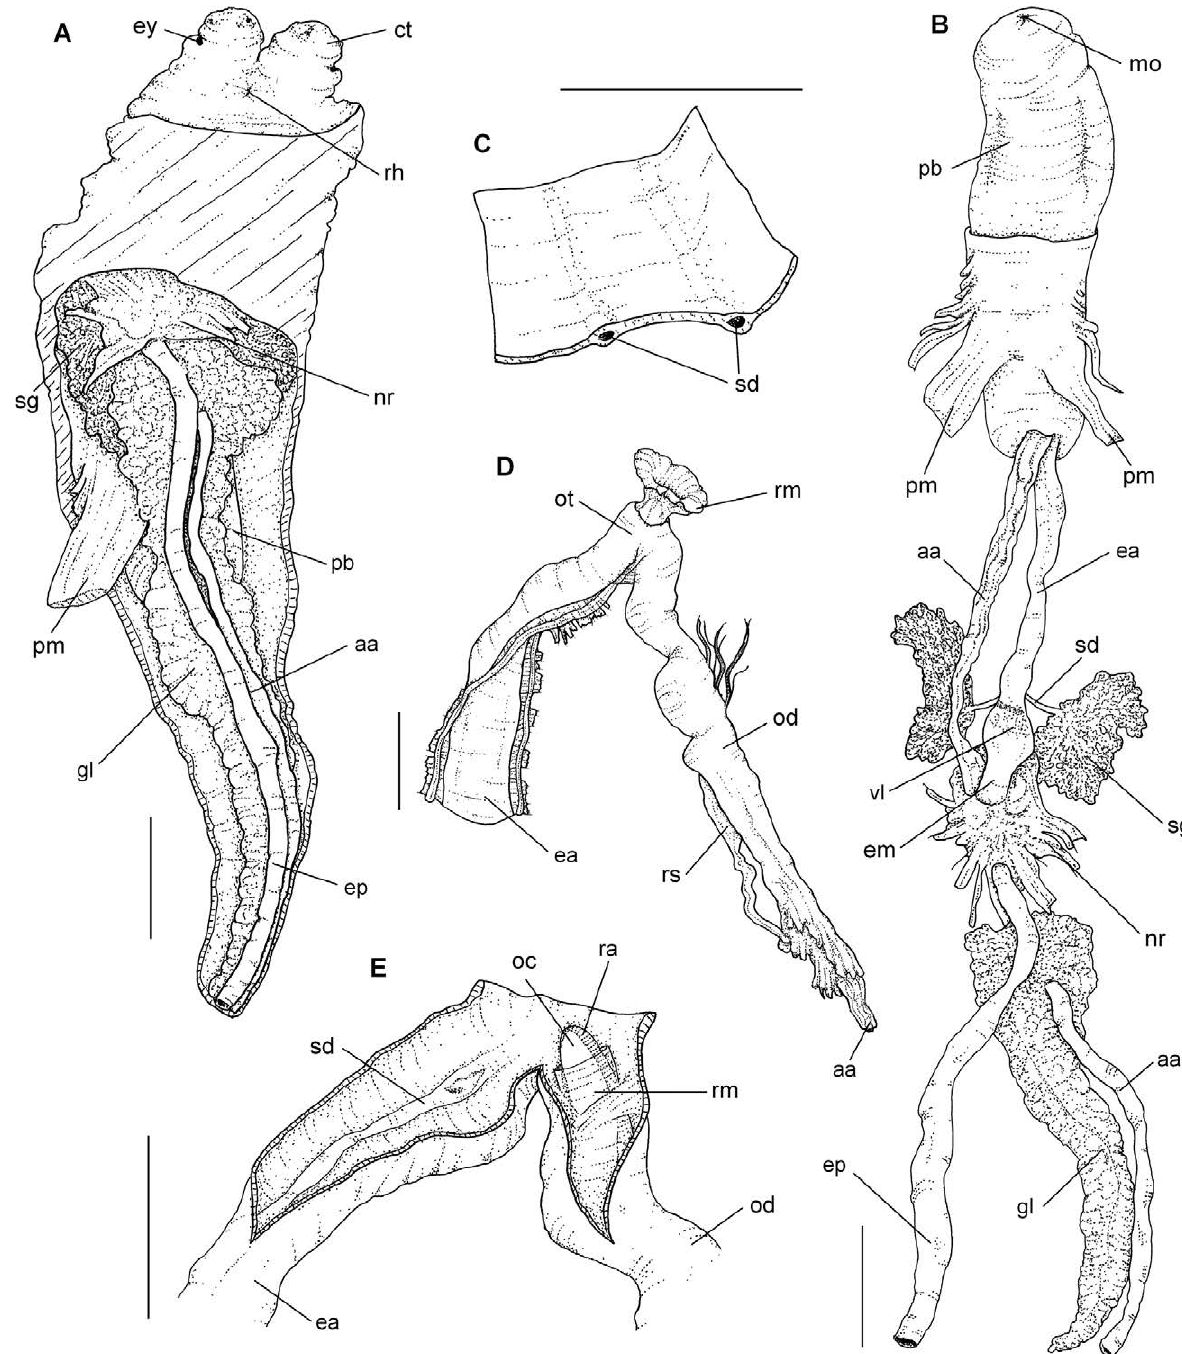
Fig. 3.- Pustulatirus ogum . A, haemocoel in ventral view; B, anterior digestive system; C, lumen of anterior esophagus; D, buccal mass in lat- eral view; E, buccal mass in lateral view, opened longitudinally. Abbreviations: aa, anterior aorta; ct, cephalic tentacle; ea, anterior esophagus; ep, posterior esophagus; ey, eye; gl, gland of Leiblein; mo, mouth opening; nr, nerve ring; oc, odontophore cartilage; od, odontophore tube; ot, oral tube; pb, proboscis; pm, proboscis retractor muscles; ra, radula; rh, rhynchostoma; rm, subradular membrane; rs, radular sac; sd, salivary gland duct; sg, salivary gland; vl, valve of Leiblein. Scale bars: A-B, 2 mm; C-E, 1